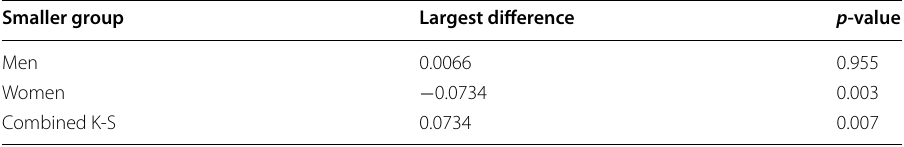
Table 10 Kolmogorov–Smirnov test for equality of k ‑max distribution functions Smaller group